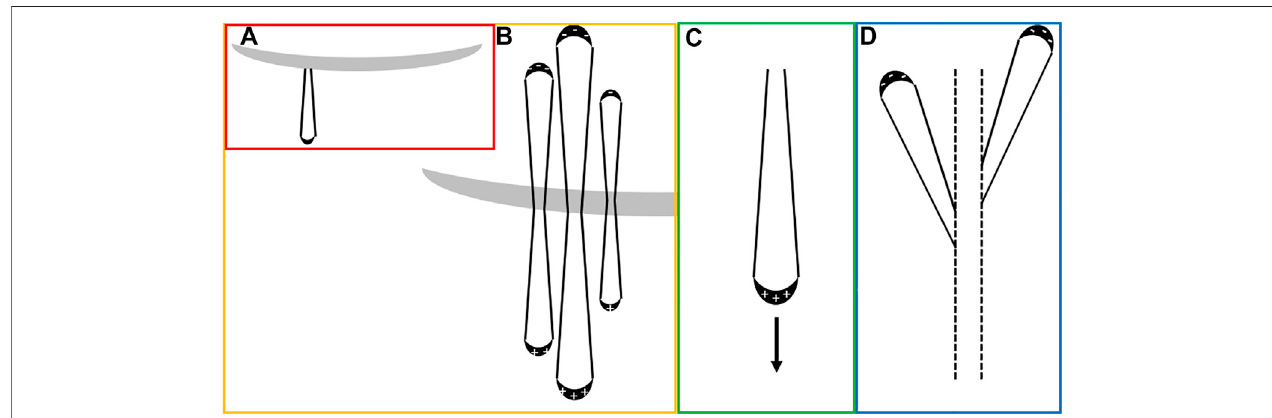
FIGURE 4 | To analyze the AP emission characteristics of each developed stage in ISUAL recorded sprites, we choose (A) sprite streamer inception, (B) upper branchesofbi-directionalstreamerswithnegativepolarity, (C) downwardpropagatingstreamerswithpositivepolarity,and (D) reignitingofupwardstreamerinthesprite body for speci fi c streamer process in Figure 3 and later used to study the AP measured emission